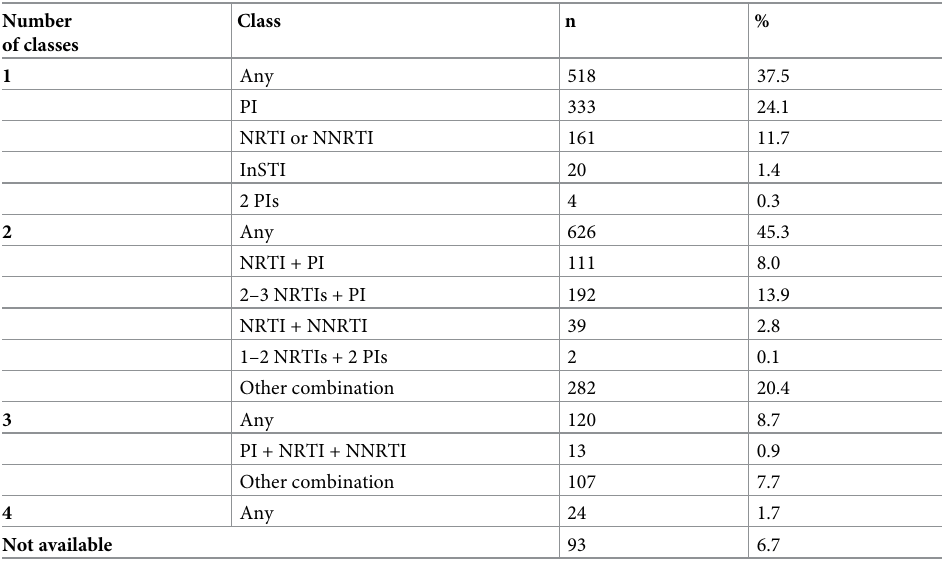
Table 3. Antiretroviral treatment classes used with maraviroc.